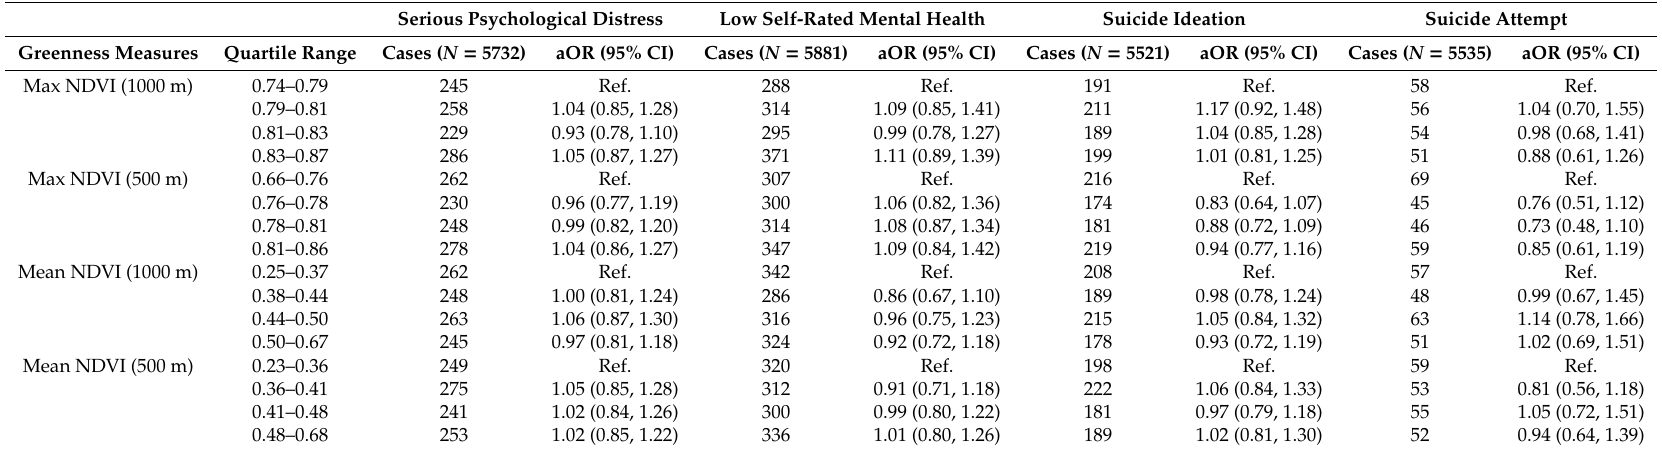
Table 2. Adjusted a odds of having poor mental health among middle- and high-school students in school neighborhoods by greenness quartile. Serious Psychological